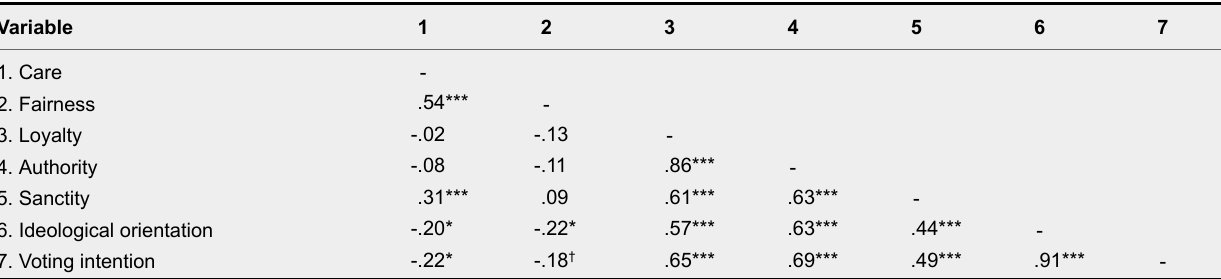
Bivariate Correlations Between Moral Foundation Endorsement, Ideological Orientation, and Voting Intention for the Incumbent Right-Wing Candidate (Formigoni) vs. the Major Left-Wing Challenger (Penati), Study 2 (N = 105) Variable